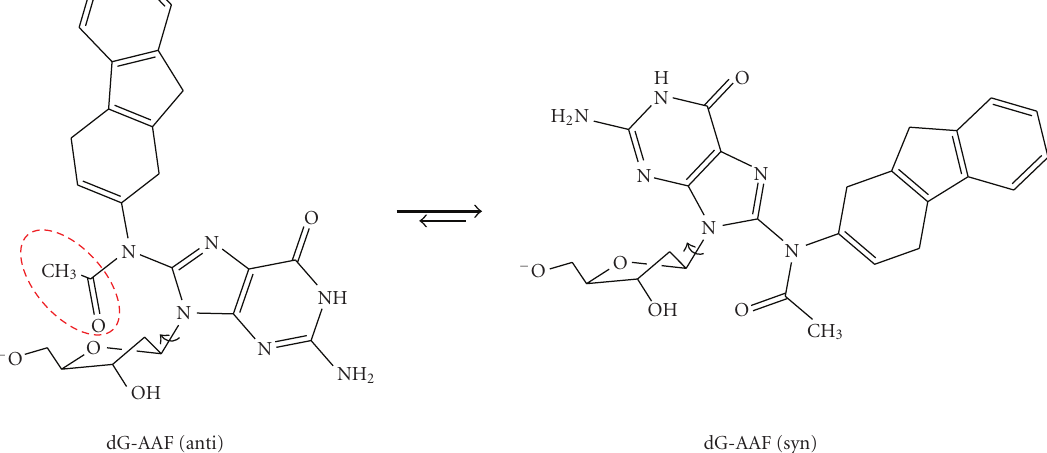
Figure 3: Conformations of a dG-C8-AAF adduct. Native DNA favors the anti conformation that allows Watson-Crick base pairs to form with the opposing strand while a dG-C8-AAF in the anti conformation results in a steric clash between the acetyl moiety (circled red) and the ribose. This causes the conformational equilibrium to shift towards the more favorable syn conformation. dG-C8-AF adducts di ff er from dG-C8-AAF adducts by having a smaller hydrogen in place of the circled acetyl moiety. This avoids the steric clash and allows both the syn- and anti conformations to be